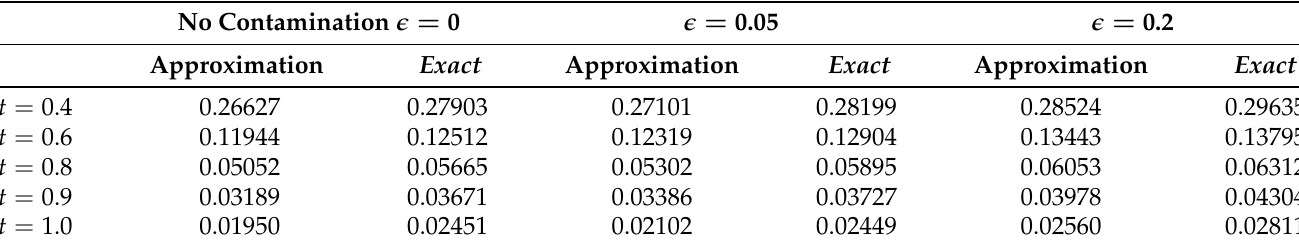
Table 1. Tail probabilities of the VOM+SAD approximation and the exact (simulated) values for the method-of-moments estimator of Figure 1.